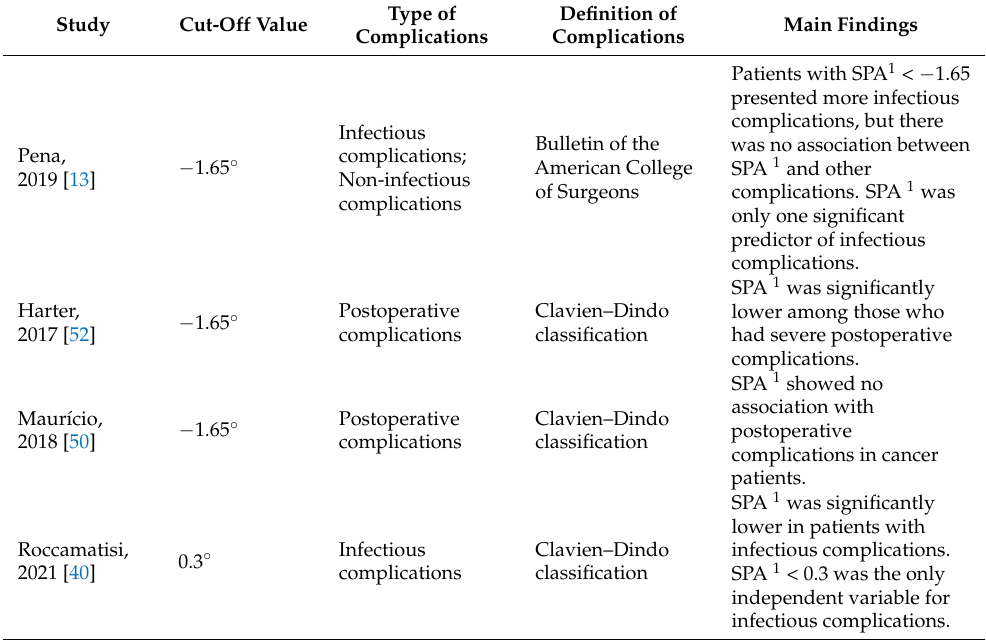
Table 5. Relationship between SPA and